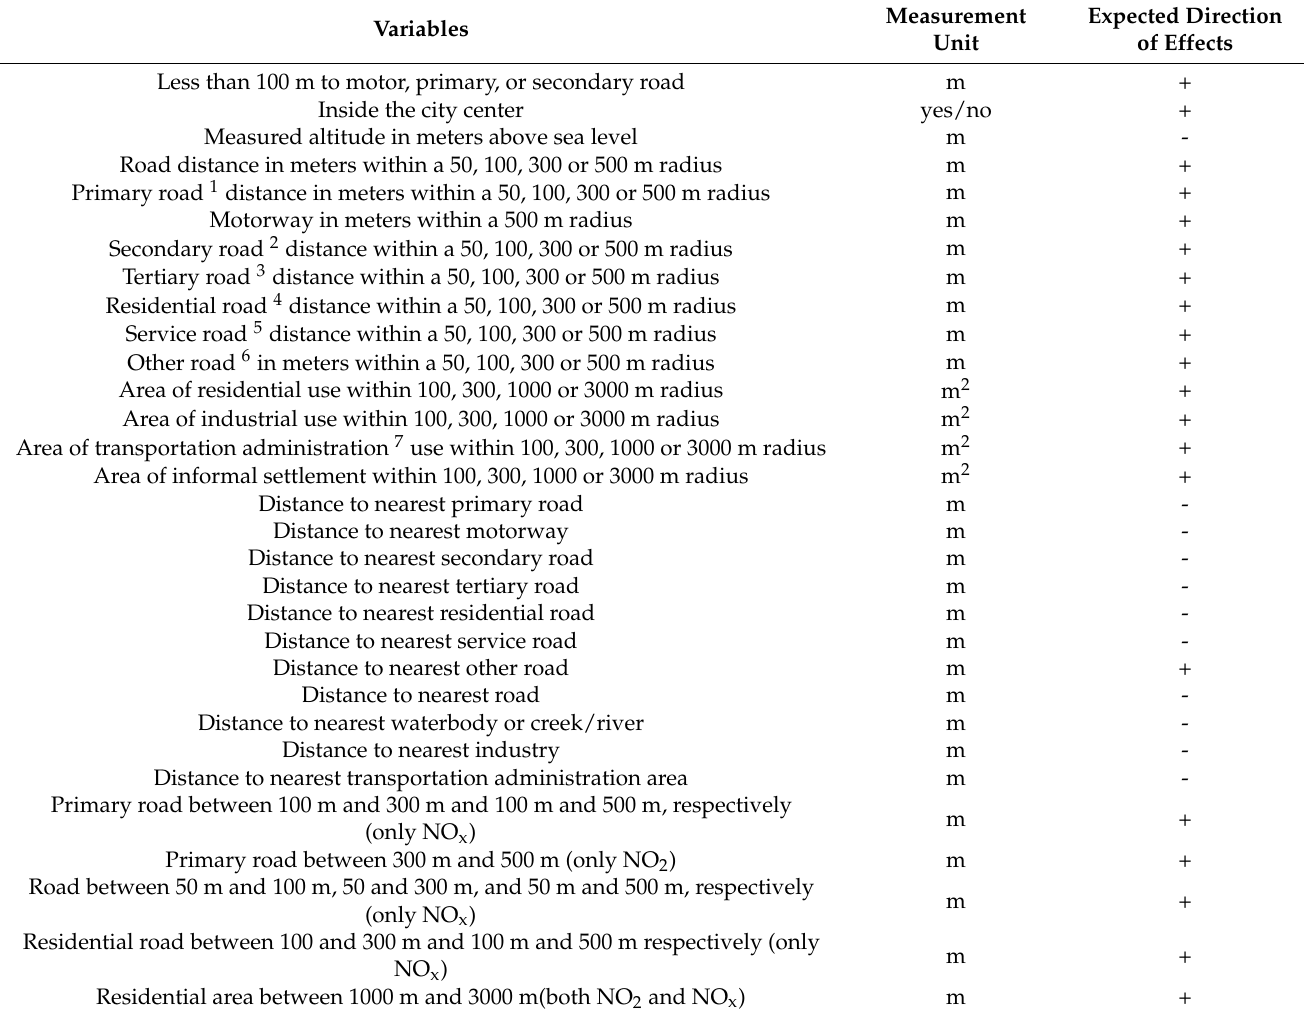
Measurement Expected Direction Unit of Effects